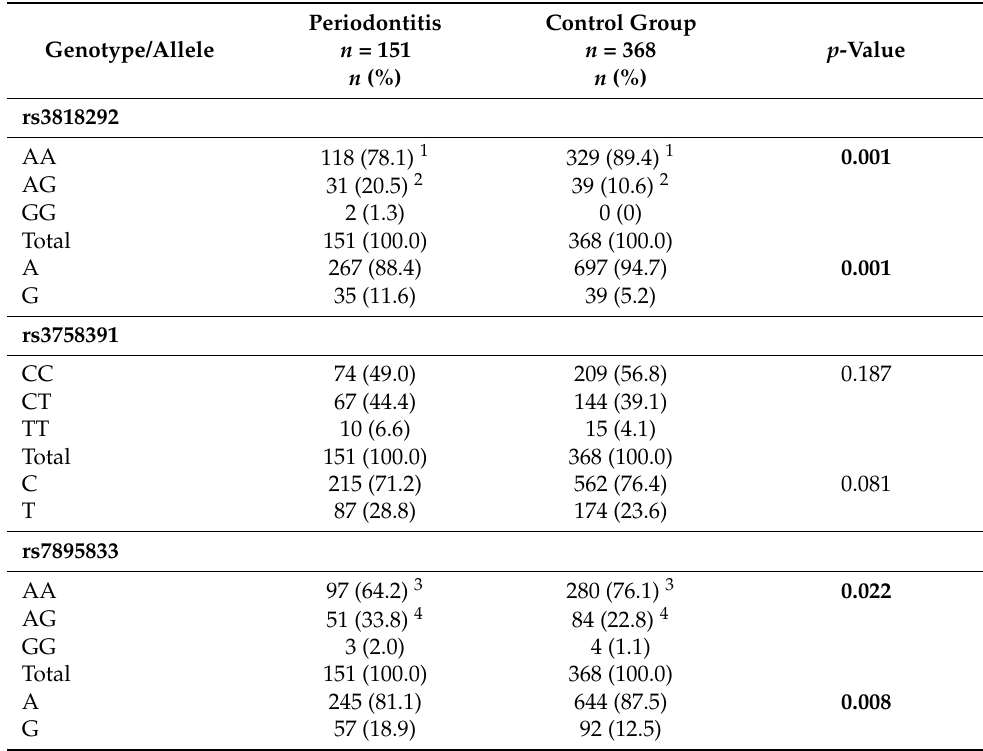
Table 7. Genotype and allele distribution of SIRT1 rs3818292, rs3758391, and rs7895833 in periodonti- tis and control groups between patients older than 60 years old. Control Periodontitis n = 151 Genotype/Allele